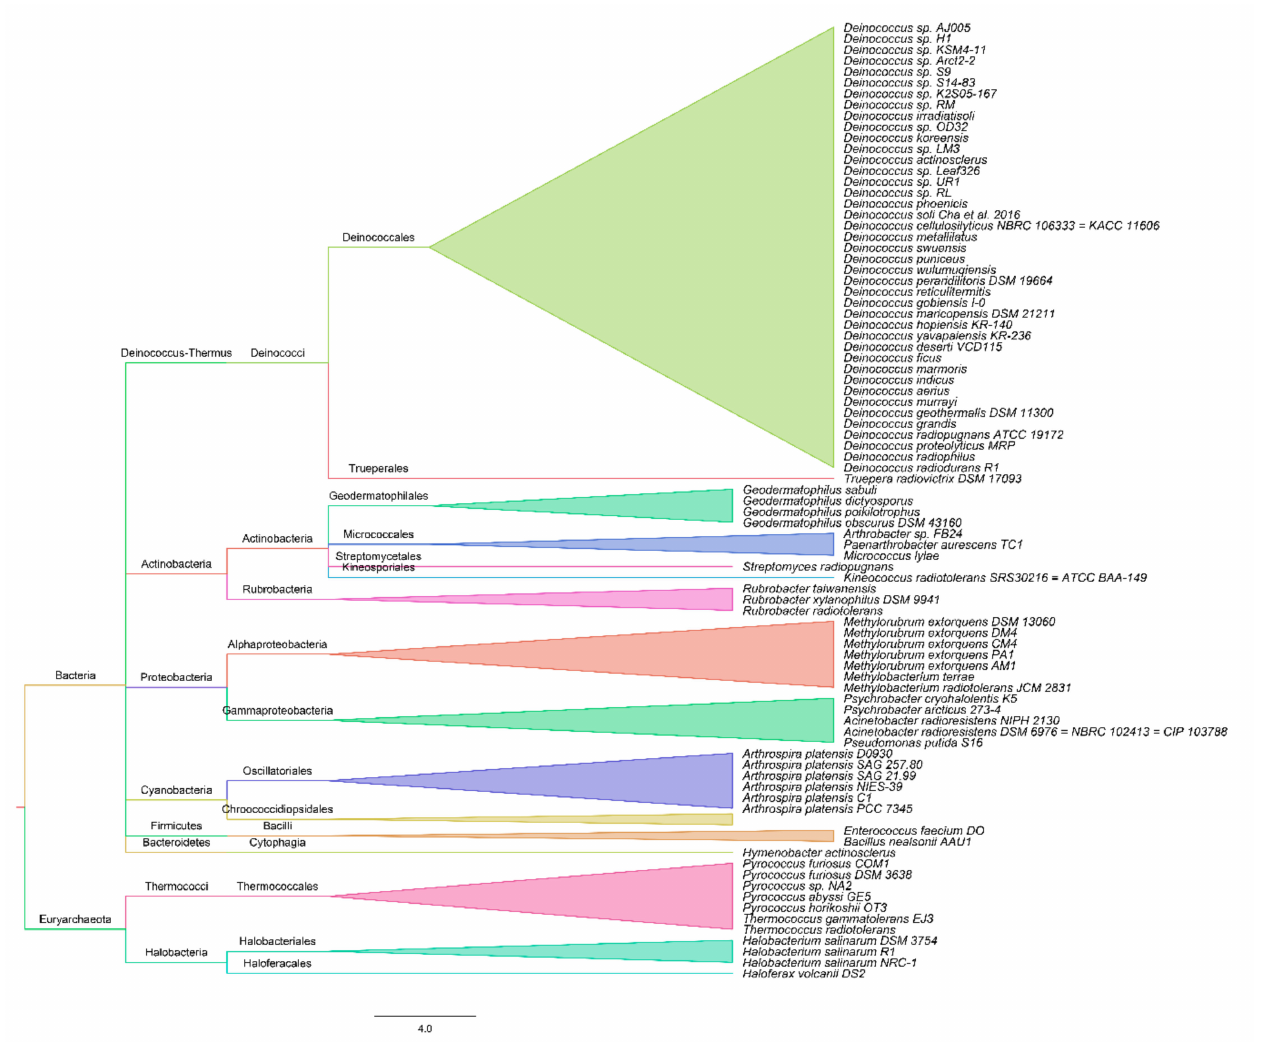
Figure 1. Phylogenetic tree containing microbial species included in the Determinants of Radioresistance Database (DetR